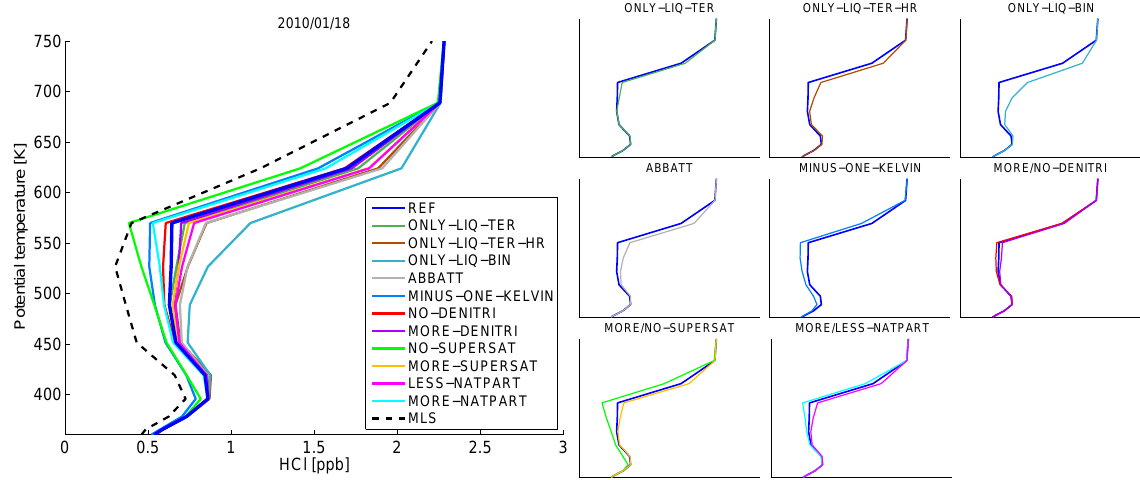
Fig. 5. Vortex-averaged HCl for 18 January 2010 as a function of potential temperature for all sensitivity runs and the reference run. The different sensitivity runs are represented by different colours. The black dashed line shows corresponding HCl measurements from MLS. Vortex average as in Fig. 1. The small plots on the right show only one or two sensitivity runs and the reference run at the same time for